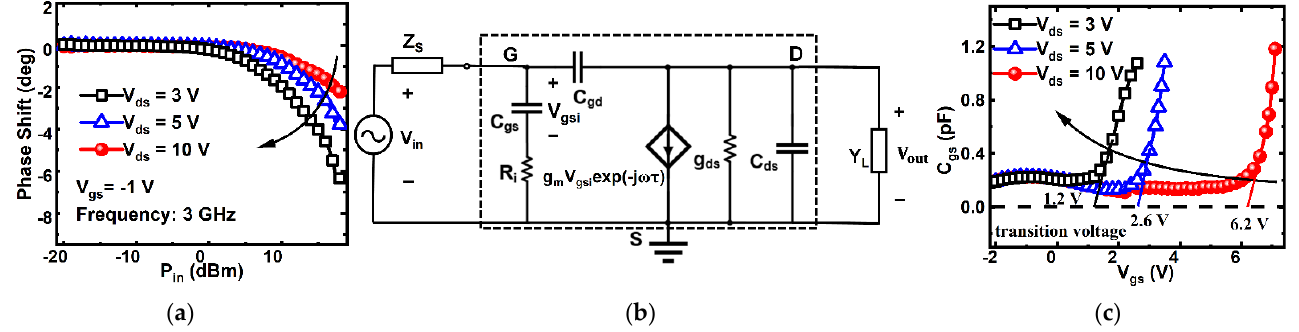
Figure 6. ( a ) Phase shift versus P in with different V ds ; ( b ) small RF signal equivalent circuit for GaN HEMT; ( c ) C gs versus gate voltage.